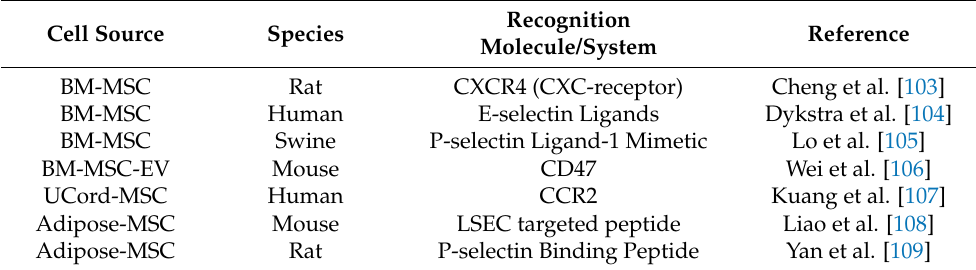
Recognition Reference Molecule/System